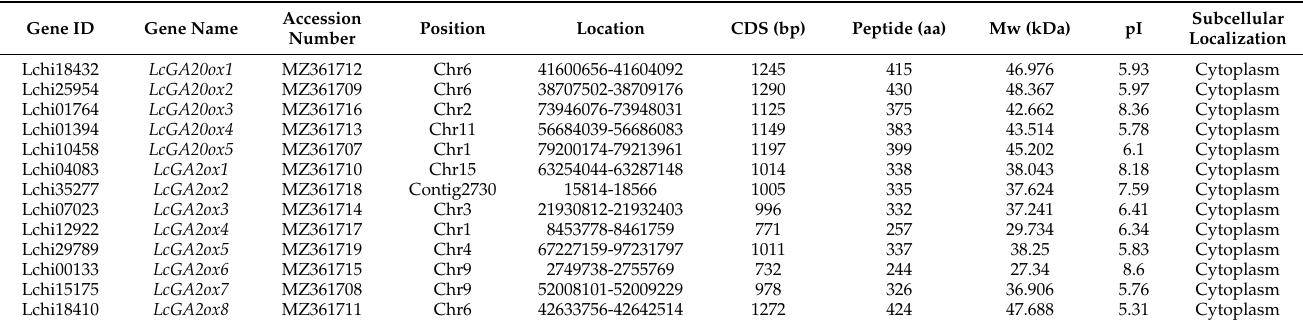
Table 2. Summary of LcGA0x gene family